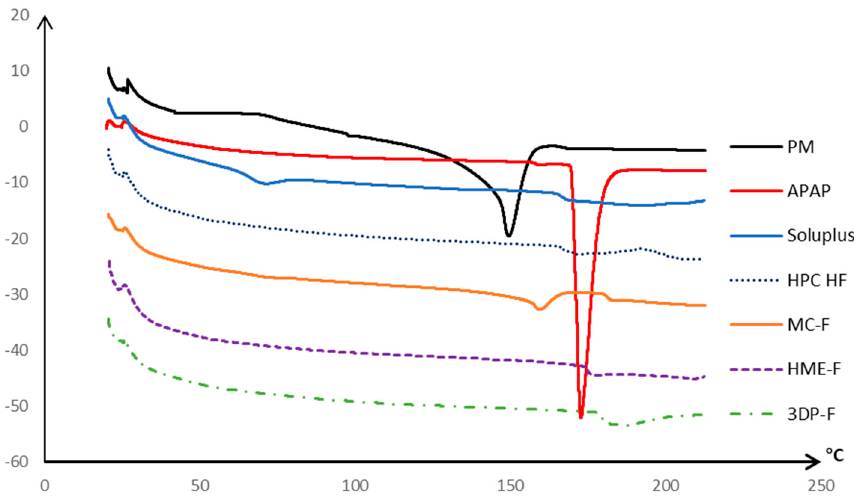
Figure 4. The DSC curves of the raw materials, MC-F, HME-F, and 3DP-F.